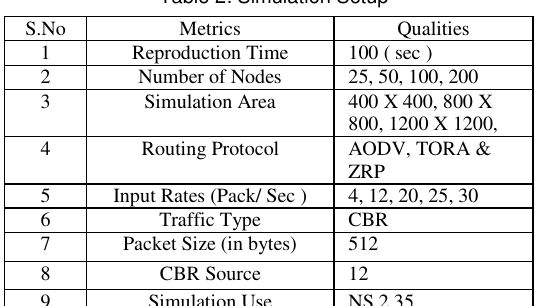
Table 2: Simulation Setup